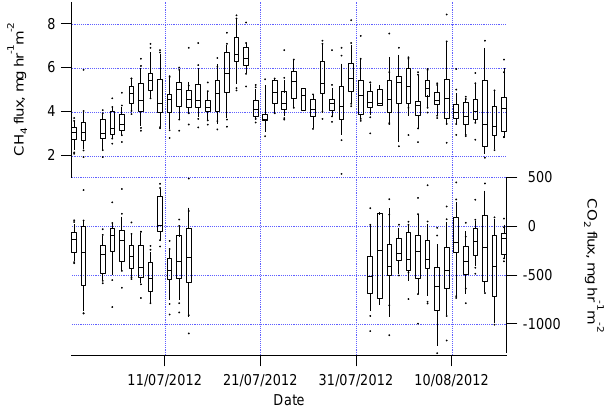
Figure 8. Daytime (06:00–18:00) CH 4 and CO 2 fluxes at So- dankylä wetland site between 1 July and 15 August 2012 deter- mined using the eddy covariance technique. Note: CO 2 fluxes are not shown for the period 14 July 2012 to 1 August 2012 as it was not possible to calibrate the LI-7200’s CO 2 channel in that